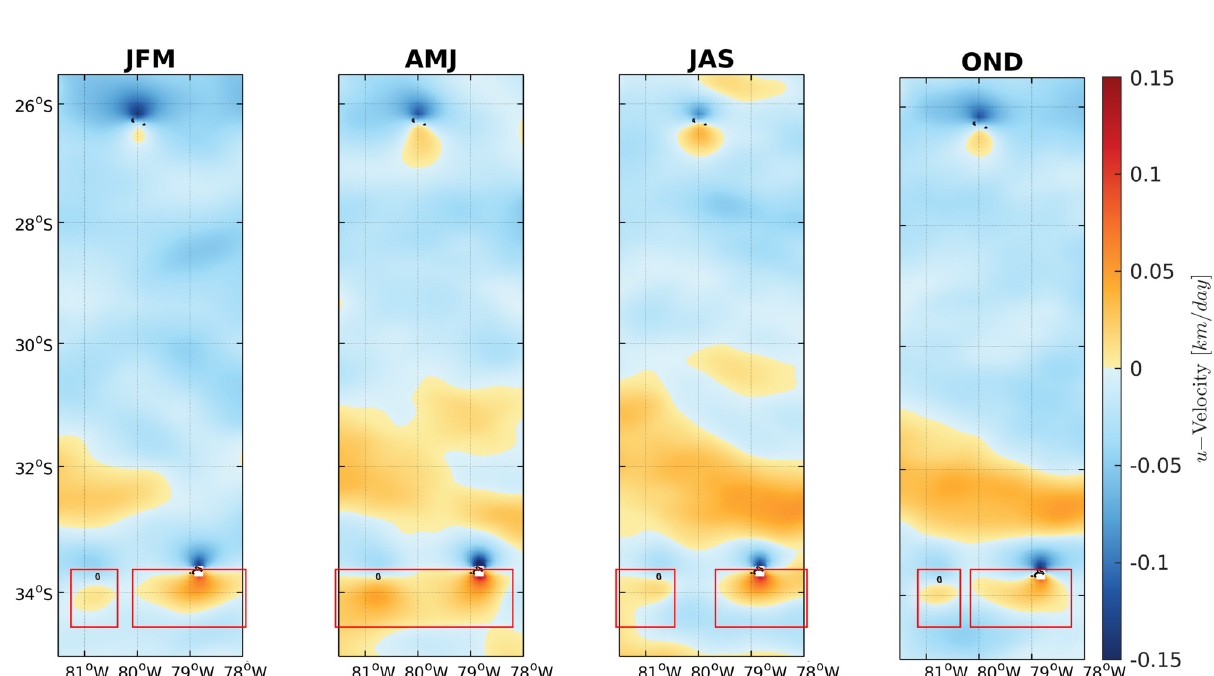
Fig 6. Seasonal (JFM, summer; AMJ, fall; JAS, winter; OND, spring) longitudinal (positive, westward; negative, eastward) velocities averaged over the first 100 m in the Juan Fernandez Archipelago and the Desventuradas Islands, 25.5–35˚S and 81.5–78˚W. Data was obtained with Copernicus model products freely distributed by CMEMS (http://marine.copernicus.eu/).